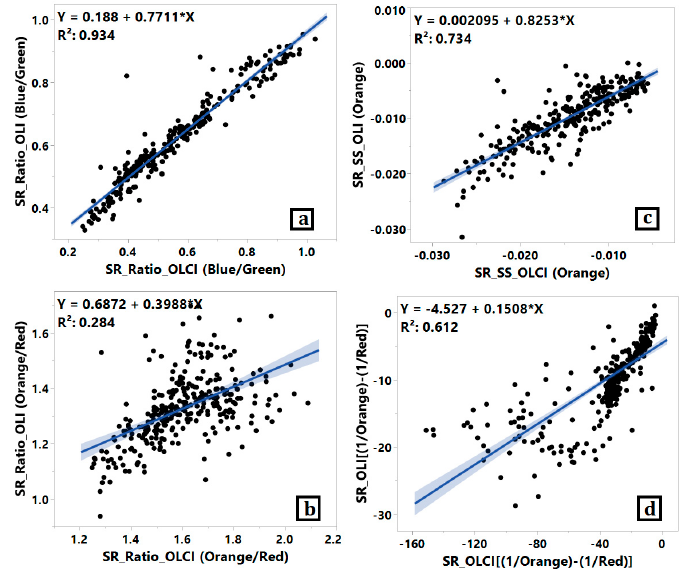
Figure 4. Regression between the OLCI- and OLI-derived SR band ratio: ( a ) blue/green, ( b ) orange/red. ( c ) Spectral shape (SS) with orange band as the central wavelength; and ( d ) the band difference of the inverse of the orange and red bands.